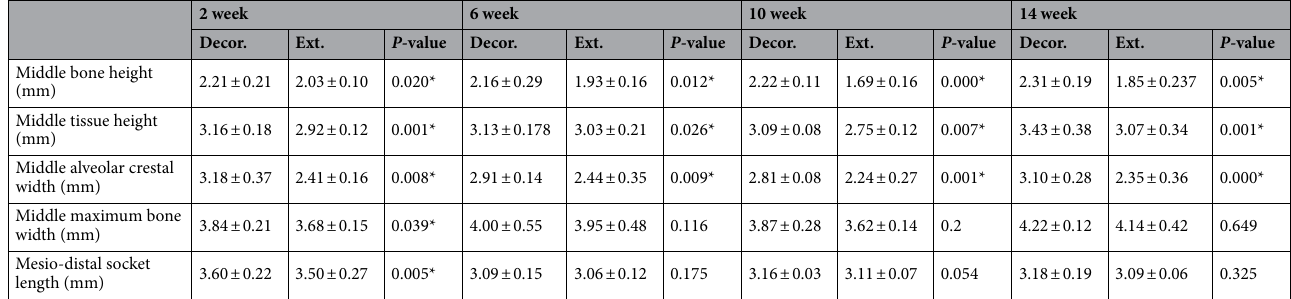
Table 3. Micro-computed tomography measurements of alveolar ridge dimension at the maxillary first molar site 2, 6, 10, or 14 weeks after decoronation (Decor.) or extraction (Ext.). Statistically significant at * P< 0.05. n = 6 per group; Data are represented as mean ± standard